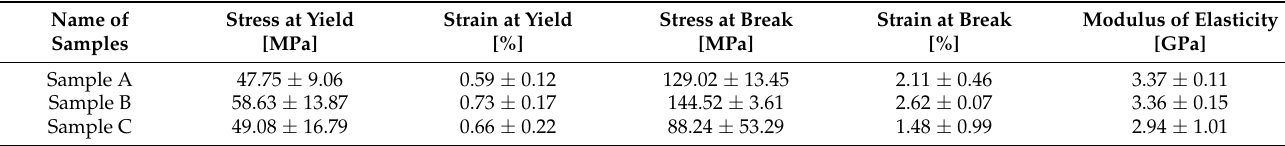
Table 3. Results of three-point bending analysis of the crystalline-form samples.